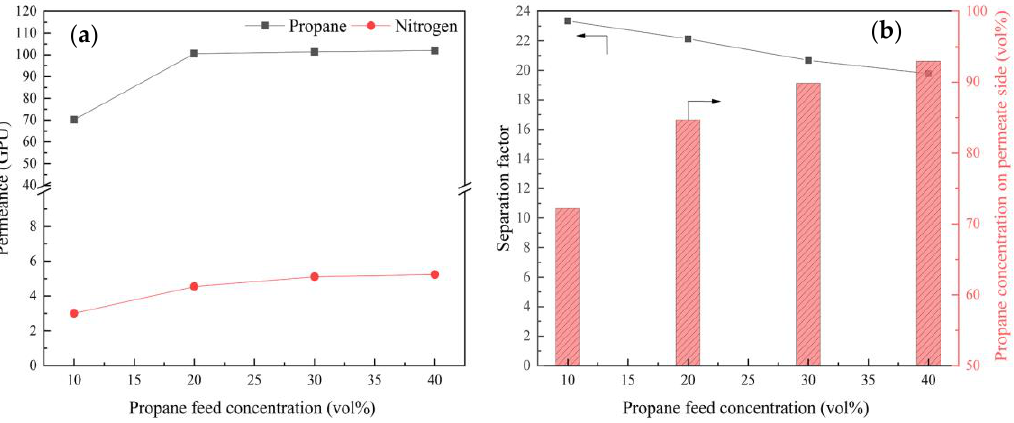
Figure 10. Effect of propane feed concentration on ( a ) separation factors and ( b ) propane permeance on operating pressure at 0.10 MPa.